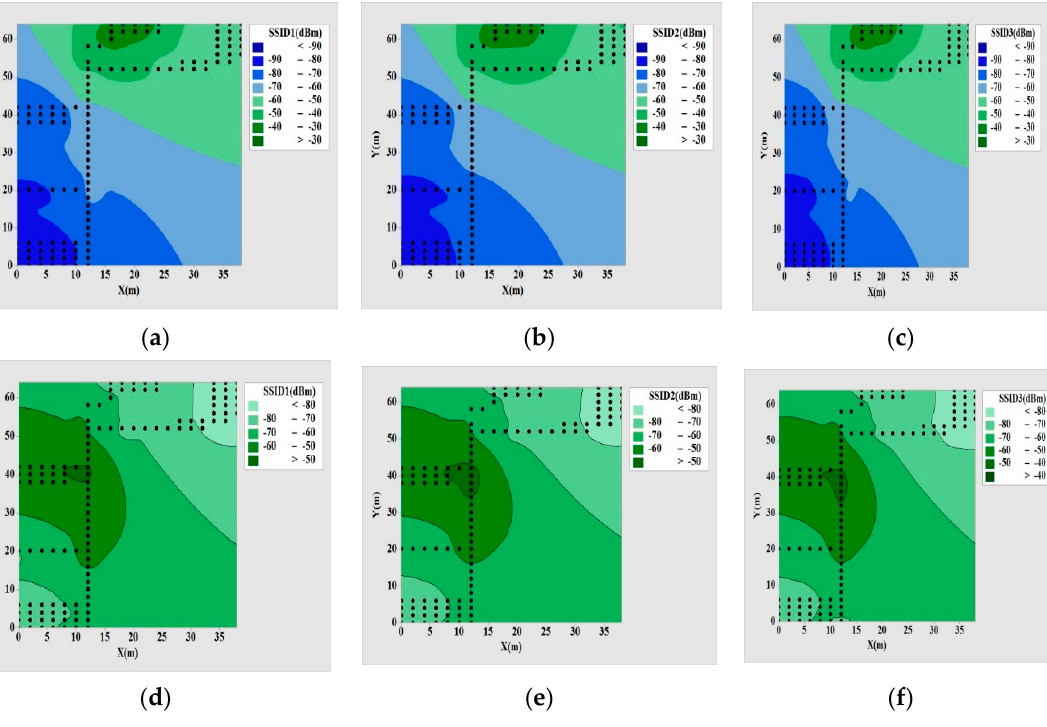
Figure 4. Spatial power distribution of two APs with three SSIDs. ( a ) SSID 1 of AP 1 ; ( b ) SSID 2 of AP 1 ; ( c ) SSID 3 of AP 1 ; ( d ) SSID 1 of AP 2 ; ( e ) SSID 2 of AP 2 ; ( f ) SSID 3 of AP 2 .